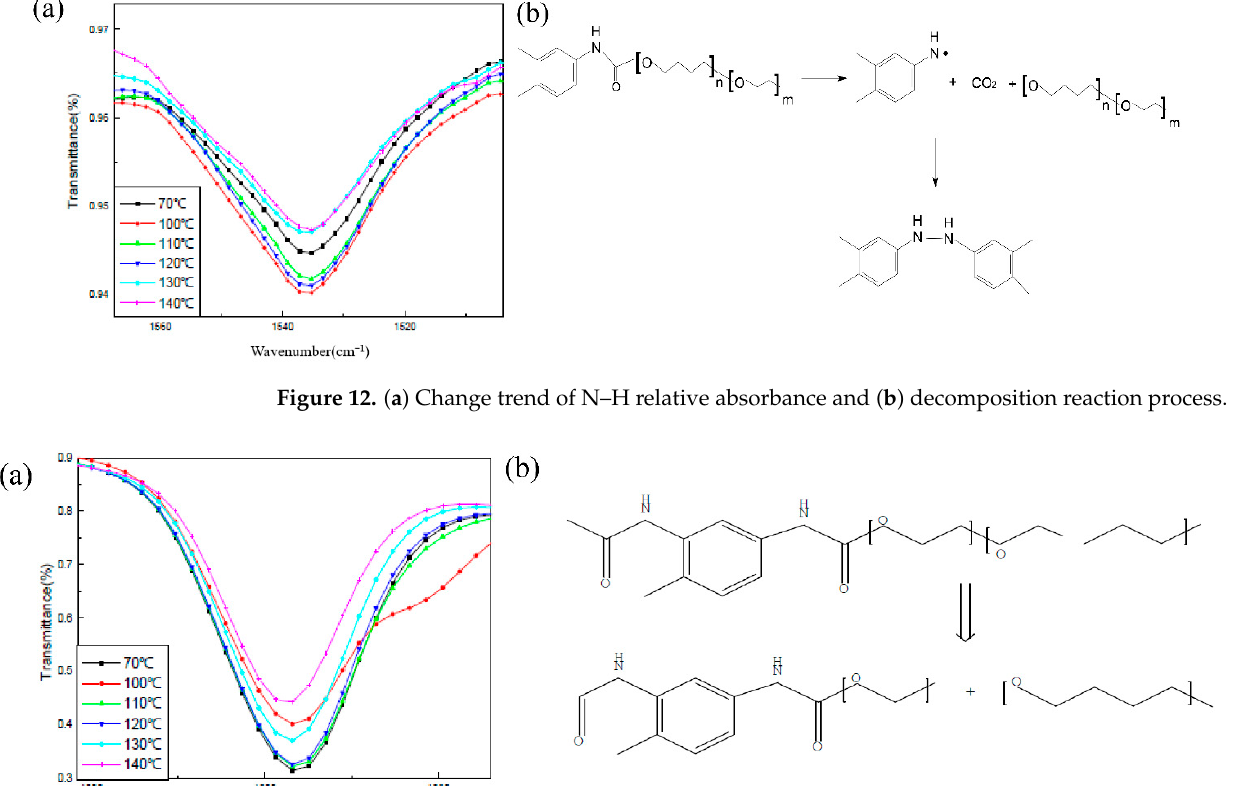
Figure 12. ( a ) Change trend of N–H relative absorbance and ( b ) decomposition reaction process.